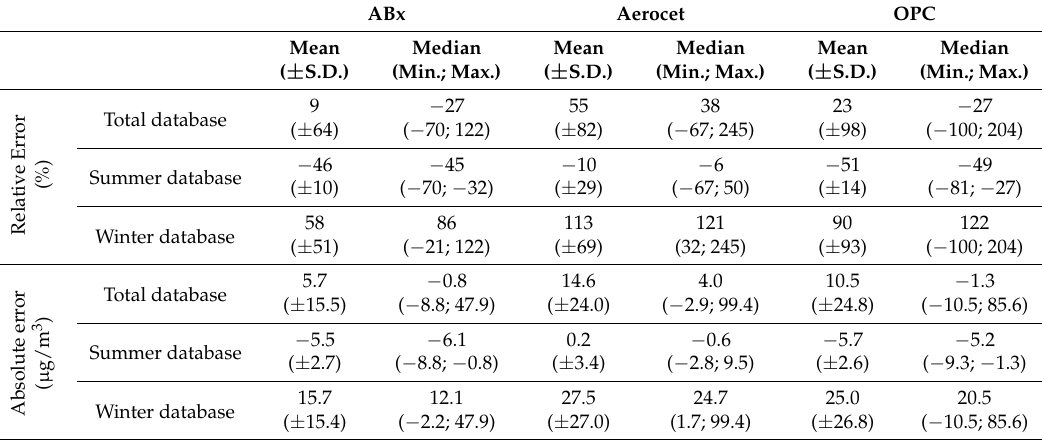
Table 11. Relative and absolute errors (mean ± S.D.; median, minimum, maximum) calculated between direct-reading instruments and the gravimetric method. The error is reported considering the mean values during summer and winter monitoring periods as well as the entire dataset. ABx Aerocet OPC Mean Median Mean Median Mean Median ( ± S.D.) (Min.; Max.) ( ± S.D.) (Min.; Max.) ( ± S.D.) (Min.;